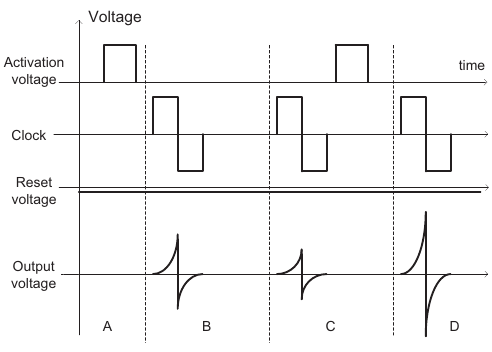
Fig. 10 : Schematic diagram of the voltage